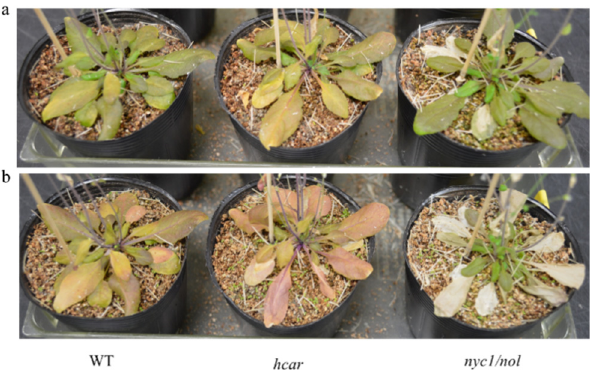
Figure 2. Phenotype of WT, hcar , and nyc1/nol plants during natural senescence: ( a ) 70-day-old WT, hcar , and nyc1/nol plants grown in soil; ( b ) 81-day-old WT, hcar , and nyc1/nol plants grown in soil.